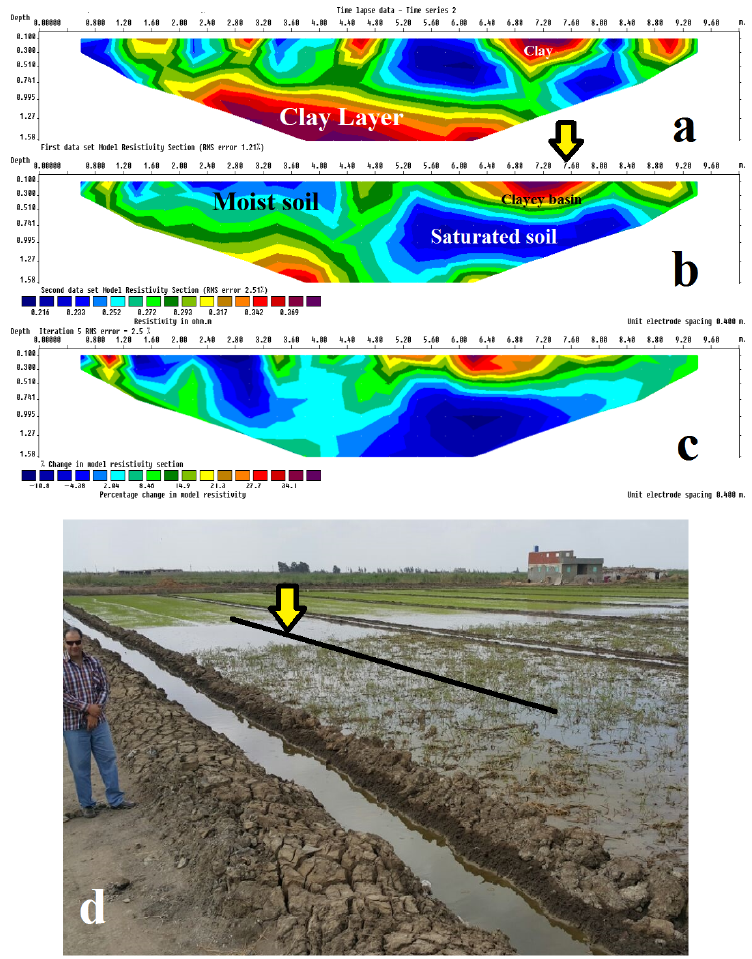
Figure 12. ERT models conducted at Farm C along the same profile in ( a ) November 2021 and ( b ) in January 2022. ( c ) The percentage change in the subsurface resistivity. ( d ) Waterlogs appeared on the farm in February 2022. The black line shows the location of the surveyed ERT profile. The yellow arrow points at the location of the compacted clay on the surface of the farm, which extends laterally to other plots and holds water after a